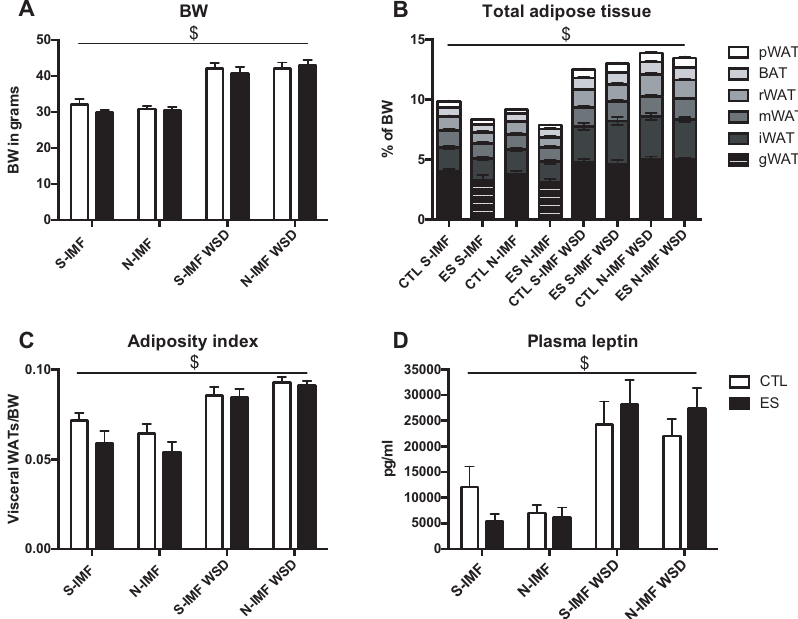
Figure 3. WSD increases general adiposity. In response to WSD, BW ( A ), total adipose tissue; white / brown adipose tissue (WAT / BAT) ( B ), adiposity index ( C ), and plasma leptin levels ( D ) are increased without modulation by ES or N-IMF. Statistical analyses were performed using three-way ANOVA. $ significant e ff ect of adult diet, p <